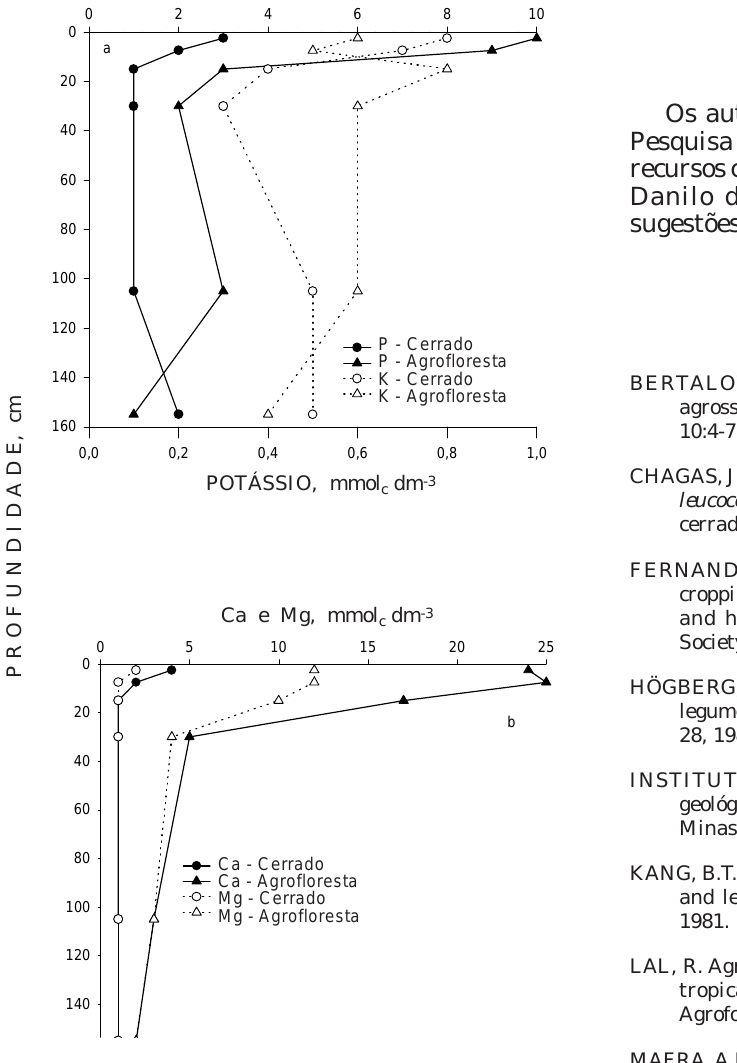
Figura 2. Teores de nutrientes no solo sob cultivo em aléias e no cerrado (a) Fósforo e potássio, (b) Cálcio e